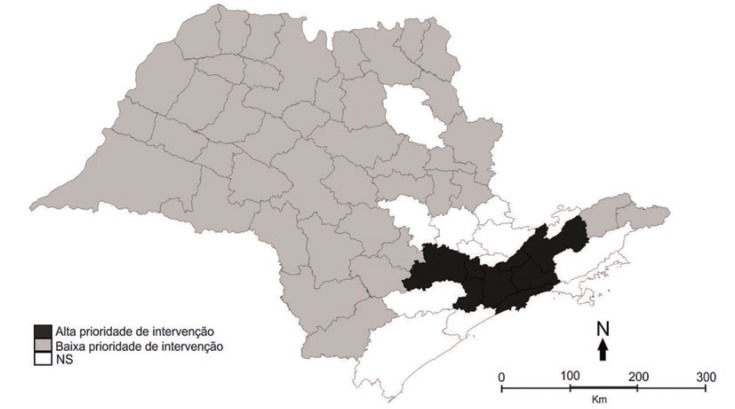
Box Map identificando microrregiões do estado de São Paulo, segundo
prioridade de intervenção Alta, Baixa e não-significante (NS) para
mortalidade neonatal, 2006-2010